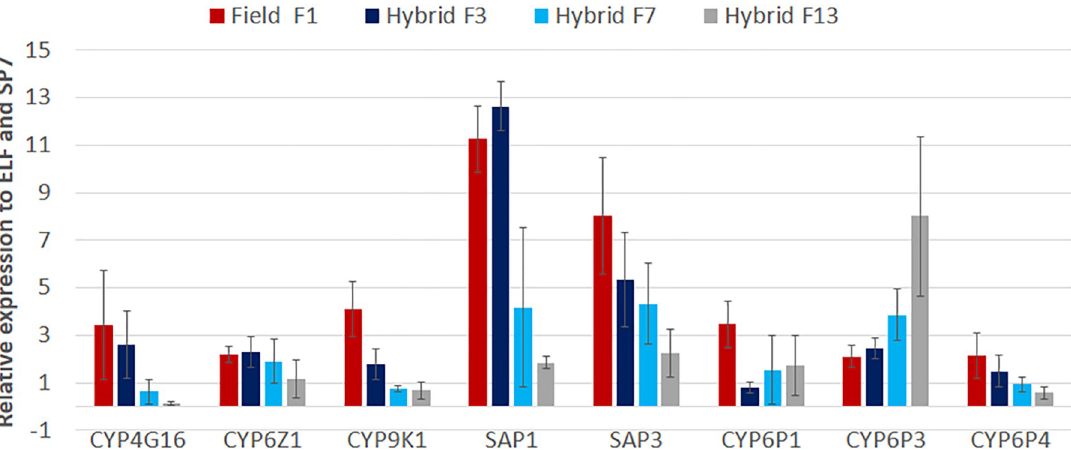
Fig 5. Differential expression by quantitative reverse-transcription polymerase chain reaction of key metabolic genes in the hybrid MYG/KIS over generation compared to field F1 unexposed. Histograms represent the fold-change of the genes in the hybrid MYG/ KIS mosquitoes across generations relative to the pyrethroid-susceptible KISUMU laboratory